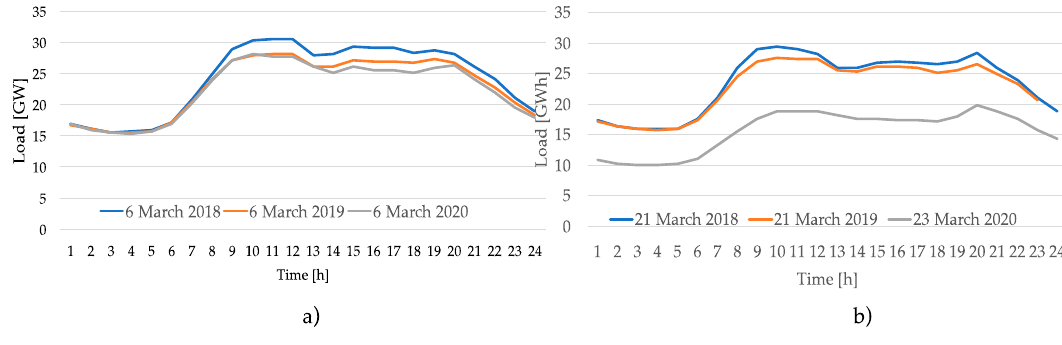
Figure 8. North Italy load profile comparison ( a ) 6th March and ( b ) 21 March 2018, 2019 and 2020.